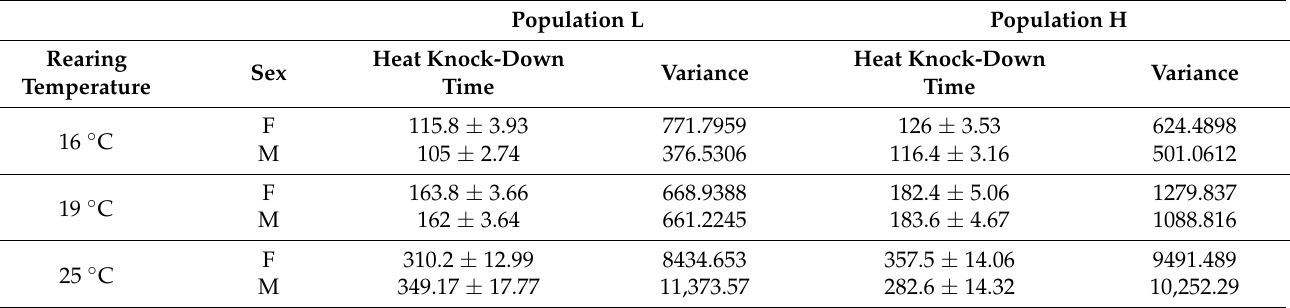
Table 2. Mean values with standard errors and variance for all groups for the heat knock-down time (measured in minutes). Population L—population originating from lower altitude; population H—population originating from higher altitude; rearing temperature—T at which flies evolve in the laboratory; F—females; M—males; heat knock-down time—time by flies have been knocked down (mean value ± SE (standard error)). This Table was previously published in Proceedings of the 1st International Electronic Conference on Entomology , 1–15 July 2021, MDPI: Basel, Switzerland, doi:10.3390/IECE-10532.